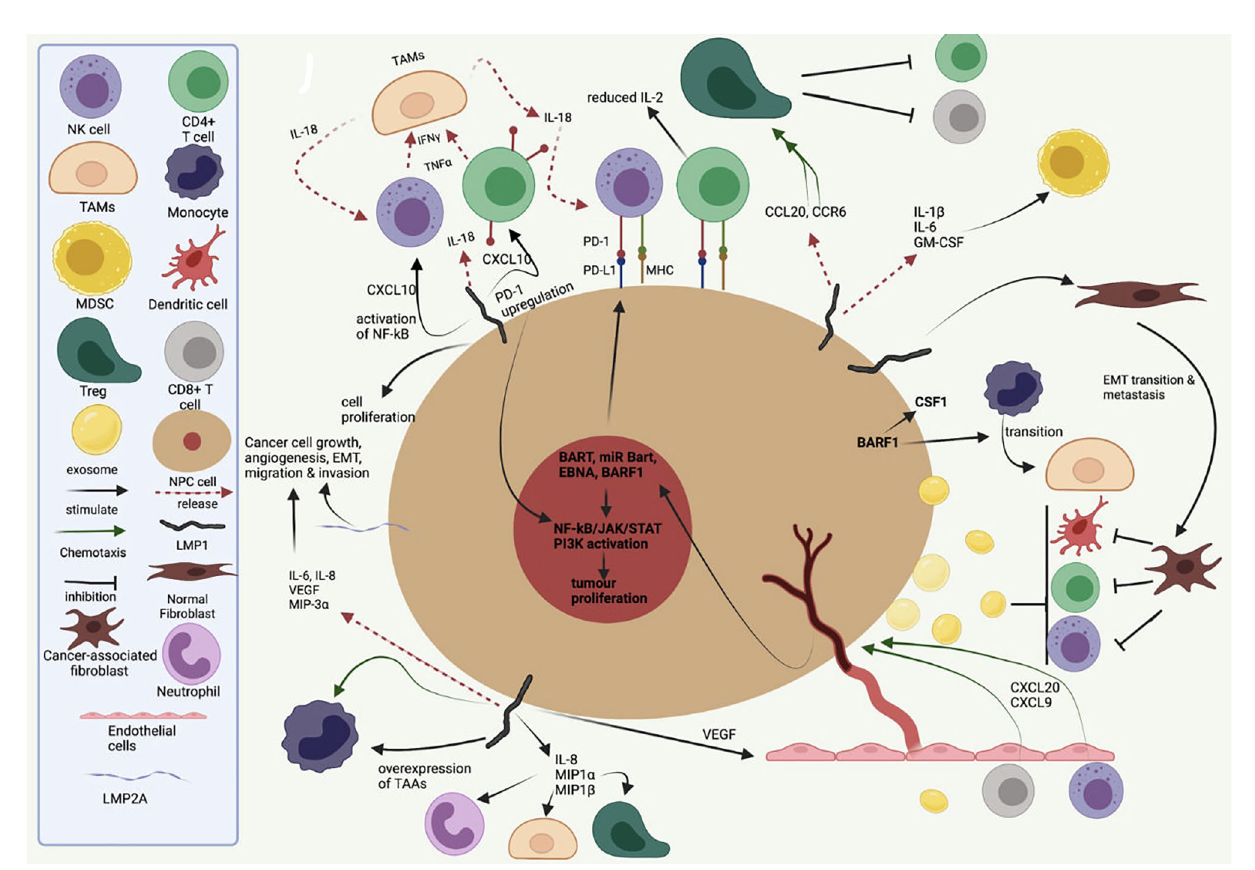
FIGURE 3 | A symbolic representation of the role of EBV latent proteins and gene products in the tumour – immune cell cross-talk, recruitment of various immune cell into the tumour – stromal microenvironment and maintaining an immunosuppressive tumour immune microenvironment. Inspired by Lo AK-F et al. The Role of EBV- Encoded LMP1 in the NPC Tumor Microenvironment: From Function to Therapy. Front Oncol. 2021;11:640207.